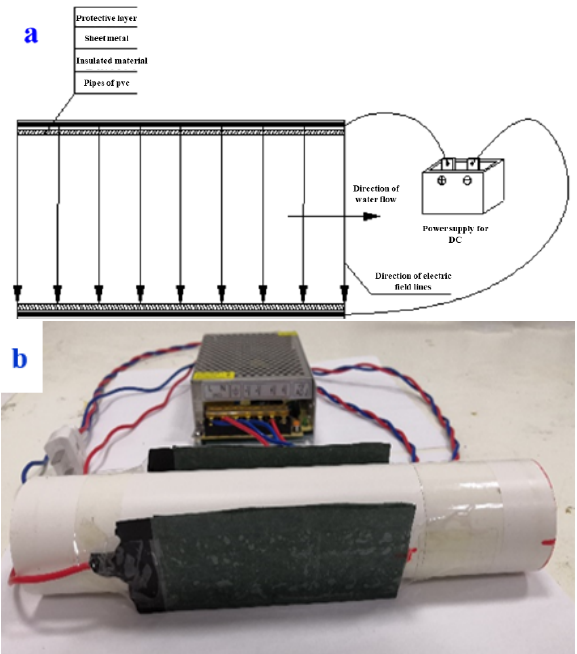
Fig. 1. Treatment device by uniform low-voltage electrostatic field (a: diagram; b: